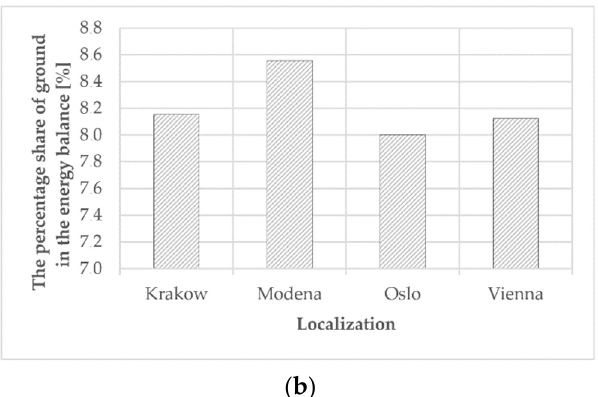
Figure 16. Heat exchange with the ground ( a ) and percentage contribution of the ground to the energy management of the broiler house ( b ), depending on location.